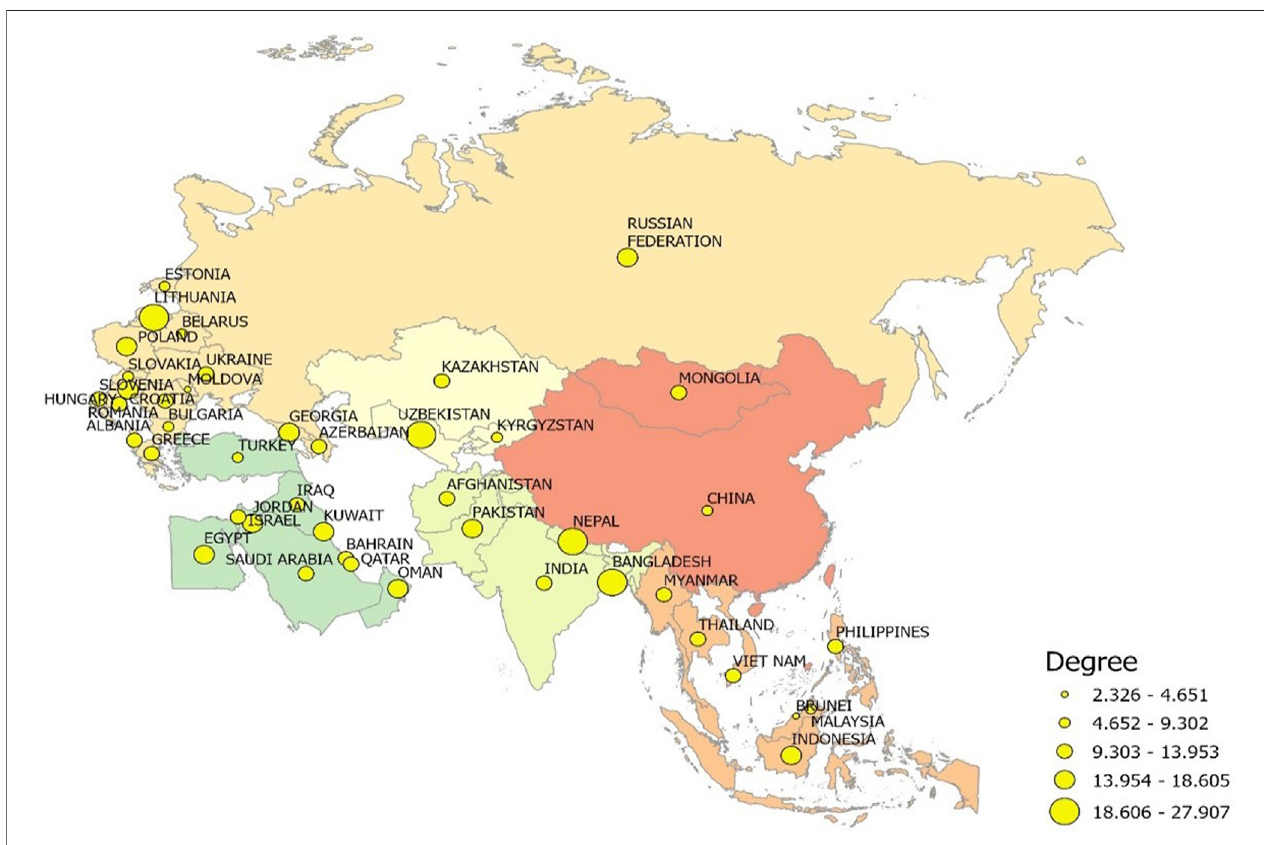
FIGURE 2 | Degree of environmental risk in the